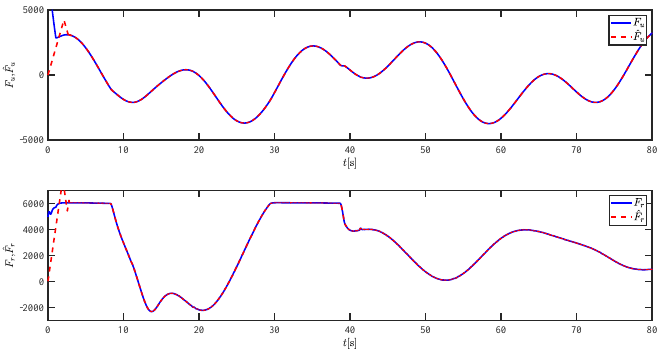
Figure 32. The lumped disturbances and their estimations under severe disturbance.